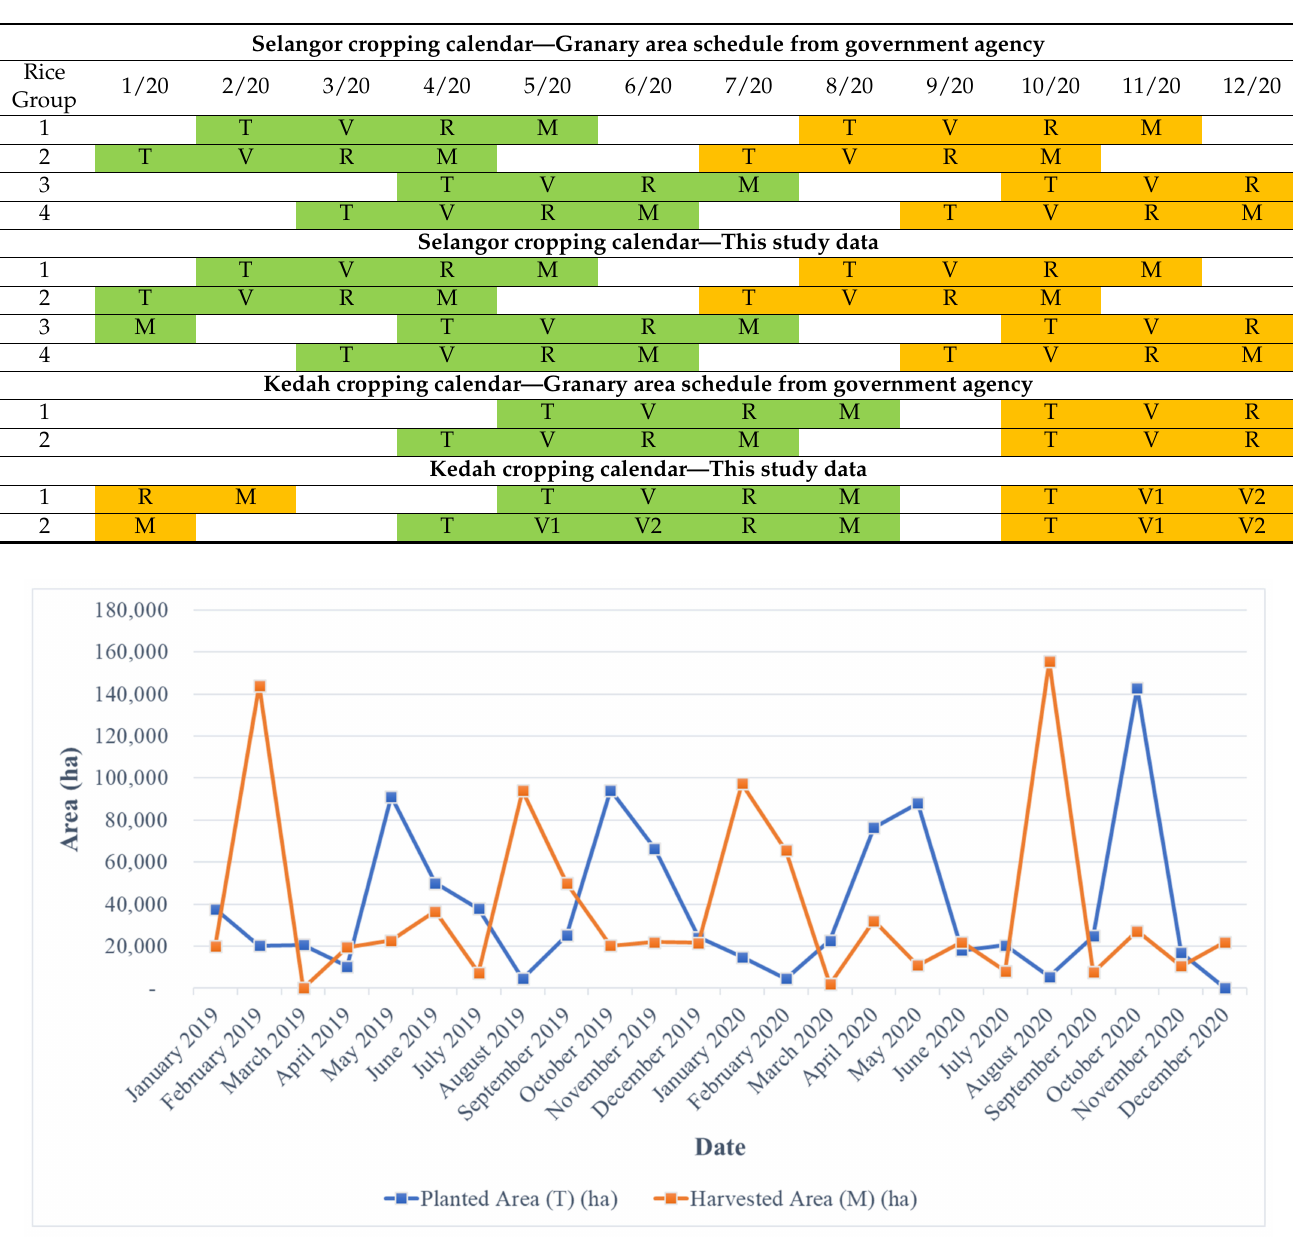
Table 4. Comparison of cropping calendars from granary area schedules and this study. Table 4 corresponds to Figure 6a,b. Table 4 corresponds to Table S1. T = Tillage, V = Vegetative-1, V2 = Vegetative-2, R = reproductive, M = Maturity, F (blank) = Fallow. Orange colour is the main season and green colour is the off season.